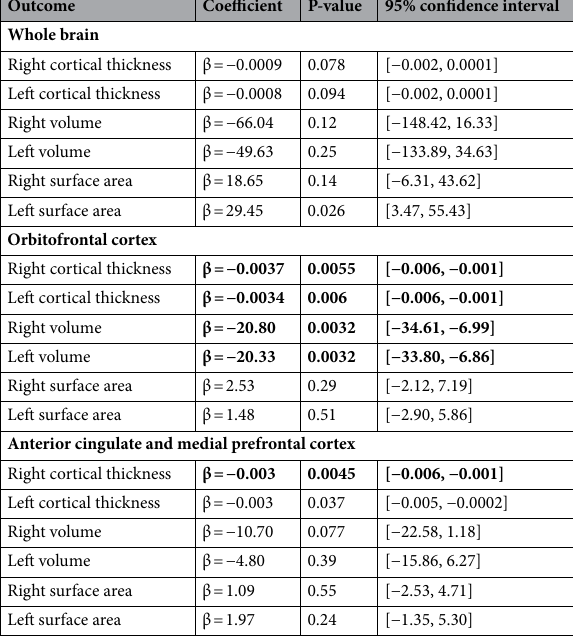
Table 2. Results for longitudinal effects of BMI at SHIP-2 on brain parameters at SHIP-3. Significant results are highlighted in bold (p<0.017); analyses are adjusted for ICV, age_2, sex, age*sex interaction, brain parameter at SHIP2 and follow-up time, volume refers to